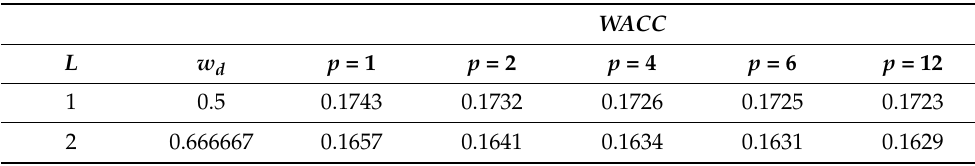
Table 5. Dependence of the weighted average cost of capital, WACC , on leverage level L at different frequency of payments of tax on profit p for six-year company.